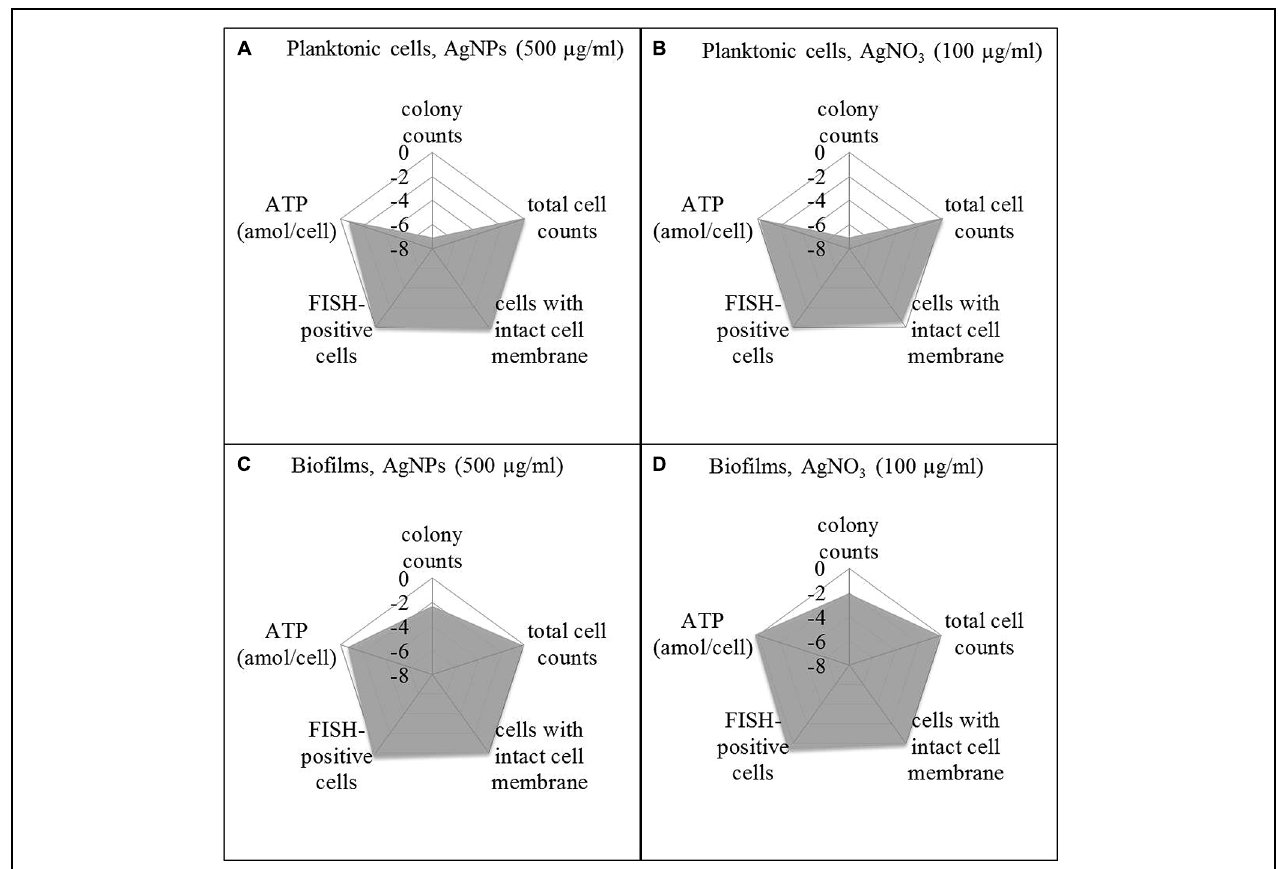
FIGURE 5 | Viability pattern of planktonic cells (A,B) and biofilms (C,D) of P. aeruginosa AdS, exposure to 500 µ g/ml AgNPs (A,C), exposure to 100 µ g/ml AgNO 3 (B,D). Axis: log N Ag /N 0 . N Ag : viability parameter in the presence of silver, N 0 : viability parameter in the absence of silver. N 0 :